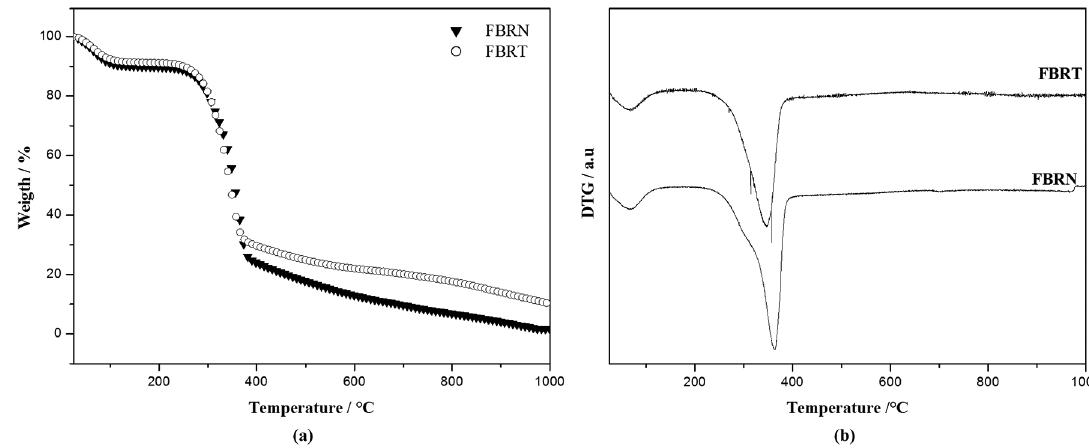
Figure 1. (a) TG; (b) DTG curves of purple banana fibers in natura and